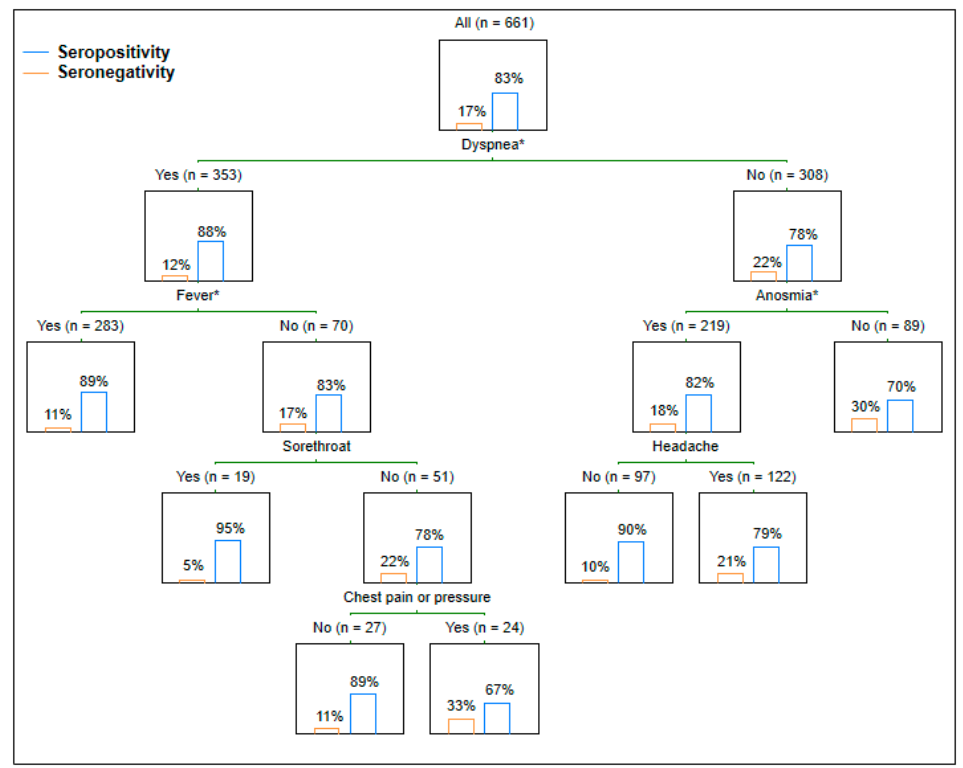
Figure 2. Immunoglobulin G seropositivity rate respectful to symptom clusters. * Statistically sig- nificant.